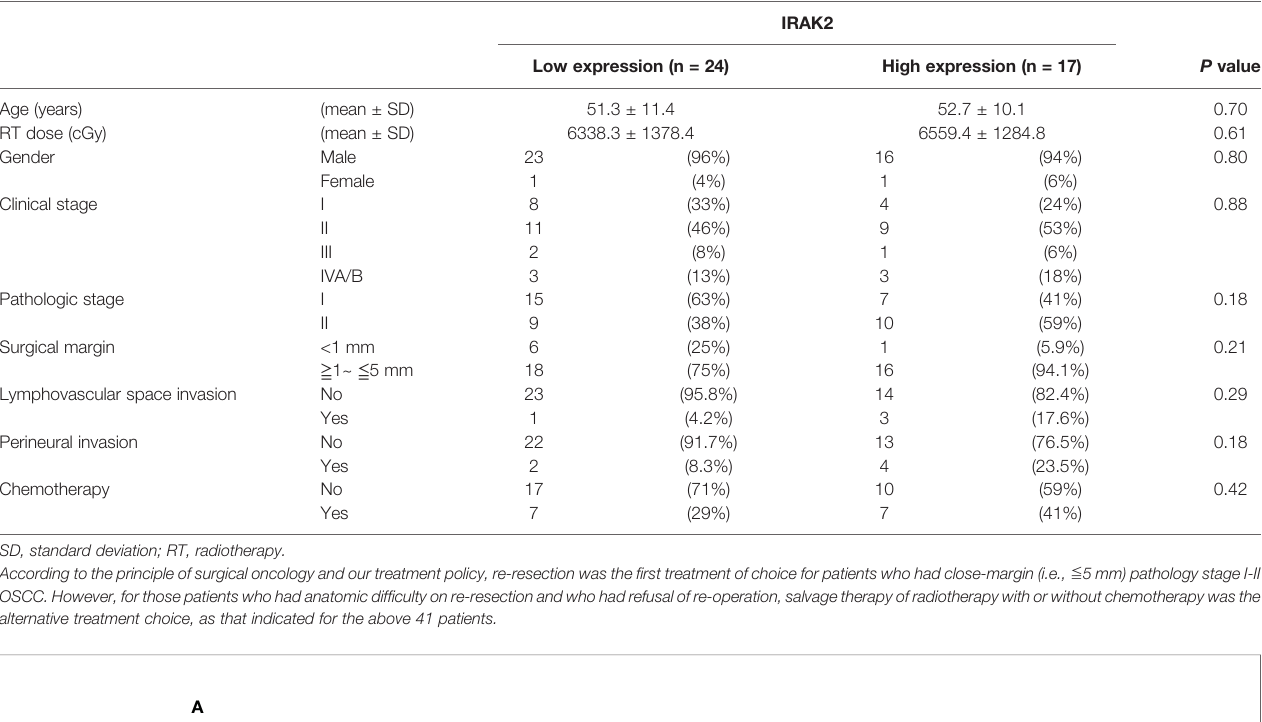
TABLE 1 | Patient characteristics of 41 oral cancer patients according to the expression level of